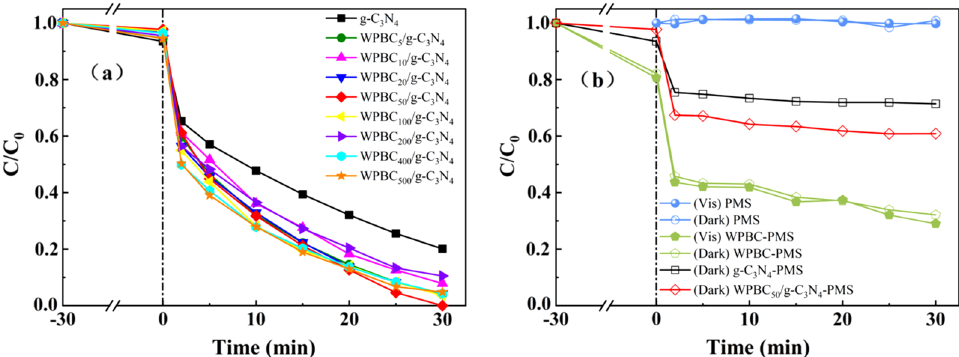
Fig. 5 a The removal efficiency of DCF in g-C WPBC/g-C 3 N 4 -PMS processes under visible light irradiation, b the DCF removal efficiency in constituent processes with and without